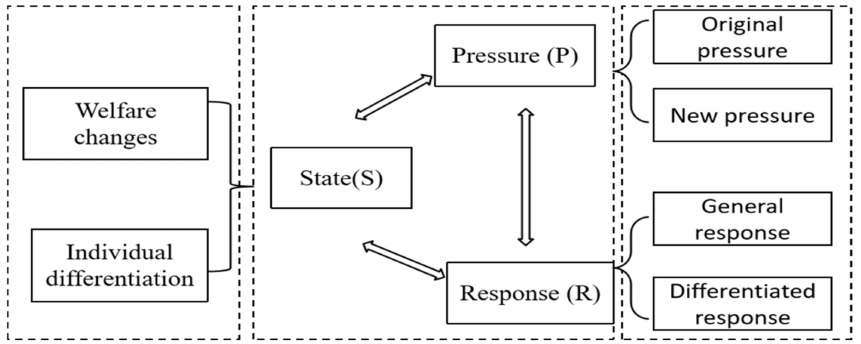
Figure 1. Sustainable regeneration PSR model from multidimensional welfare